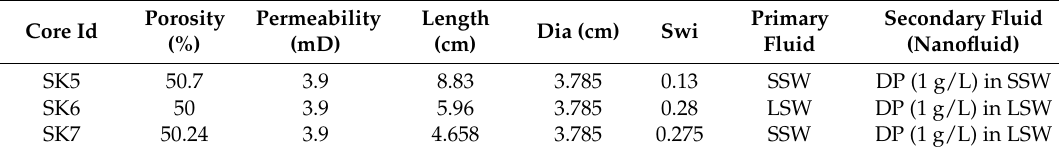
Table 4. List of nanofluid experiments with